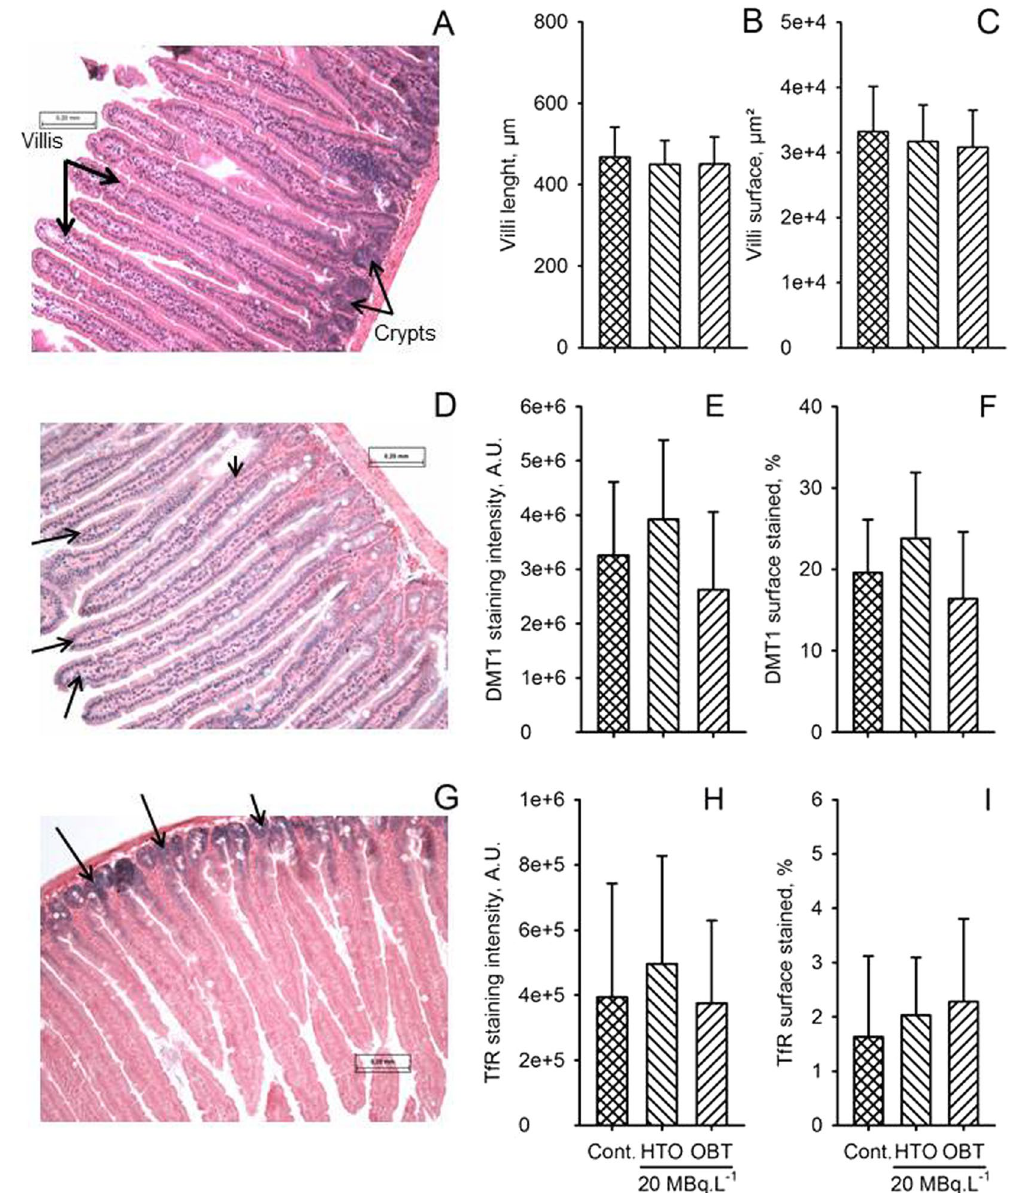
Figure 9. Histological and immuno-histological analysis of the intestine. ( A ) HES staining of intestine section, showing a normal appearance of villi (large arrow) and crypts (thin arrows). Cytoplasm is stained in pink and nuclei are stained in dark blue. ( B , C ) Morphological analysis of villi, using villi height ( B ) and villi surface for control HTO 20 MBq.l − 1 and TAA 20 MBq.l − 1 groups. No significant differences were observed between controls and exposure groups (Student’s t test). ( D ) Immuno-histological staining of intestine for DMT1 expression, appearing in dark blue (arrows), with nuclear fast red counterstaining. DMT1 is mainly expressed in the nucleus of cells in the villi and is less expressed in the basal part of the villi and in the crypt. ( E , F ) Analysis of DMT1 staining, showing that the staining intensity ( E ) and the surface stained ( F ) are not significantly modified by the exposure to either HTO or TAA as compared to the control group (Student’s t test). ( G ) Immuno- histological staining of the intestine for transferrin receptor (TfR), showing that the TfR is mainly expressed in the crypts and in the basal part of the villi. Staining for TfR appears in dark blue (arrows) with nuclear fast red counterstaining. ( H , I ) Analysis of TfR staining, showing that the staining intensity ( H ) and the surface stained ( I ) are not significantly modified by the exposure to either HTO or TAA as compared to the control group (Student’s t